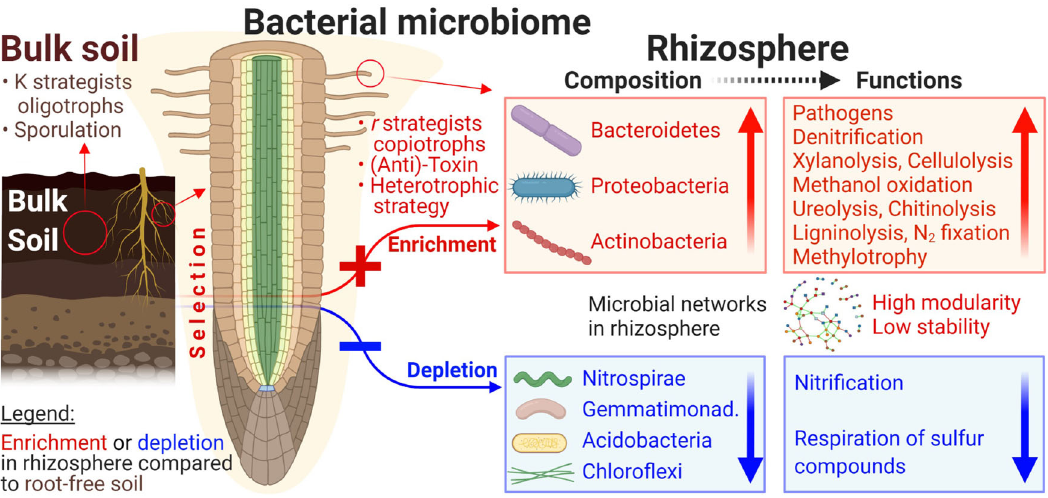
Fig. 6 Conceptual fi gure showing the enrichment (red) and depletion (blue) of bacterial community taxa and functions in the rhizosphere relative to bulk soil. The vertical arrows correspond to the intensity of the changes. The light peach-colored area around the root re fl ects the enrichment with available organics caused by